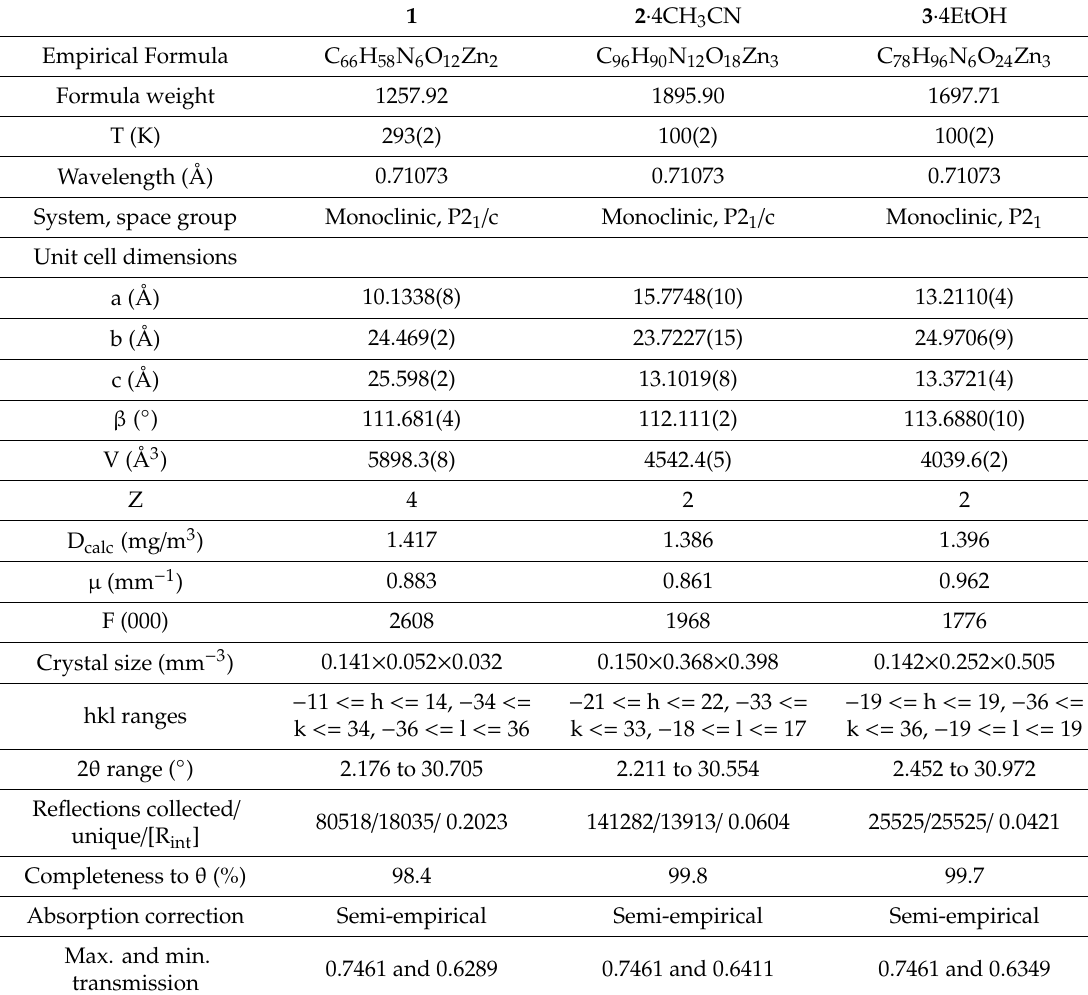
Table 5. Crystal data and structure refinement for 1 , 2 · 4CH 3 CN, and 3 ·